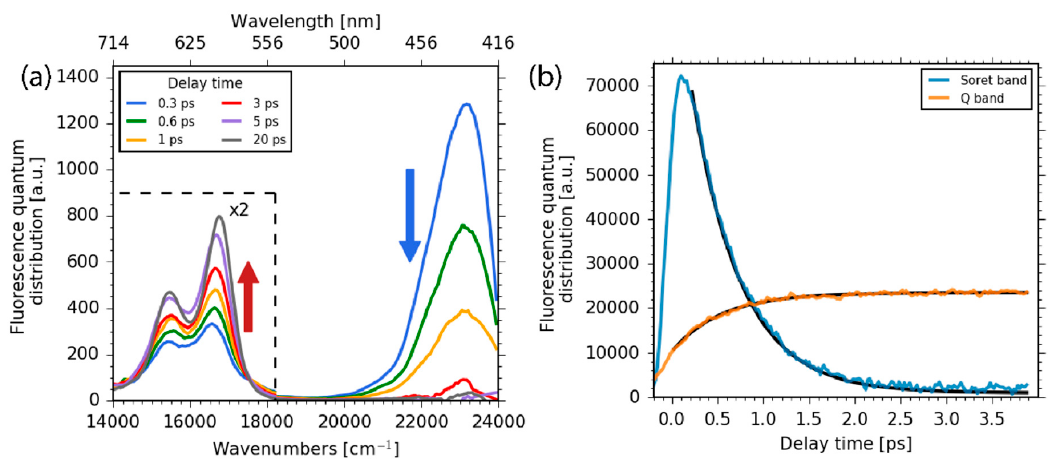
Figure 3. ( a ) Fluorescence spectra for selected delay times. The decay of the Soret band (blue arrow) and the subsequent rise of Q band fluorescence (red arrow) is clearly visible. For delay times of 5–20 ps, the two Q band fluorescence peaks shift to higher frequencies; ( b ) The integrated fluorescence transient of the Soret band region from 417 to 500 nm (blue line) and mono-exponential simulation with a time constant of 0.5 ± 0.1 ps; integrated fluorescence transients of the Q band region (orange line) with a mono-exponential rise time constant of 0.5 ± 0.1 ps.